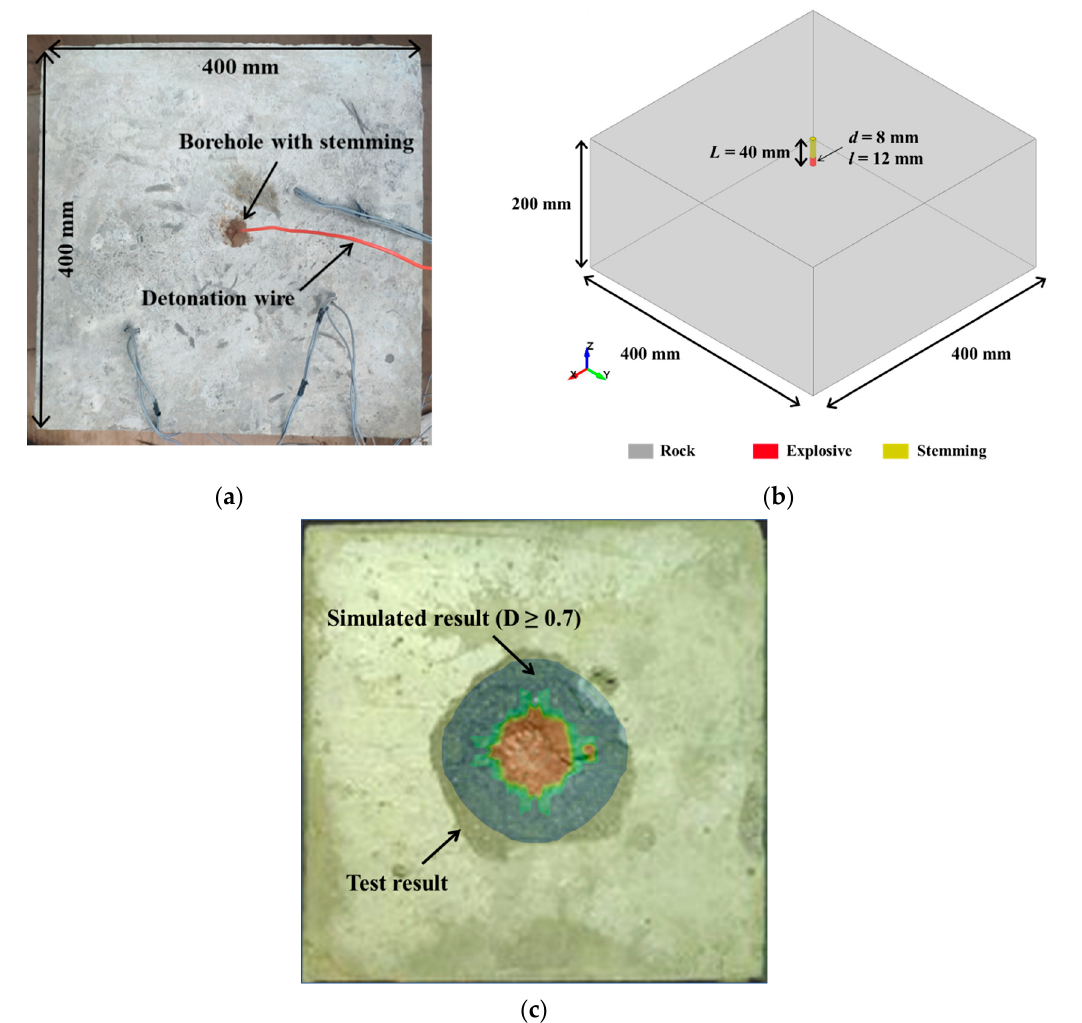
Figure 1. Single-hole crater blasting model and the comparison of explosion craters: ( a ) physical model; ( b ) numerical model; ( c ) the comparison of experimental and simulation results.